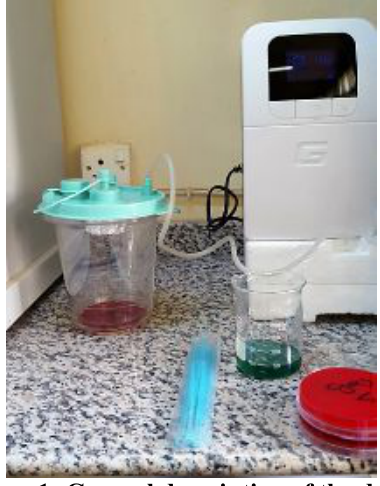
Figure 1: General description of the devise While ozonized water was generated by using special aeration stone, with concentration (0.6 ppm) measured by special CHEMets-Kit.As shown in (Fig